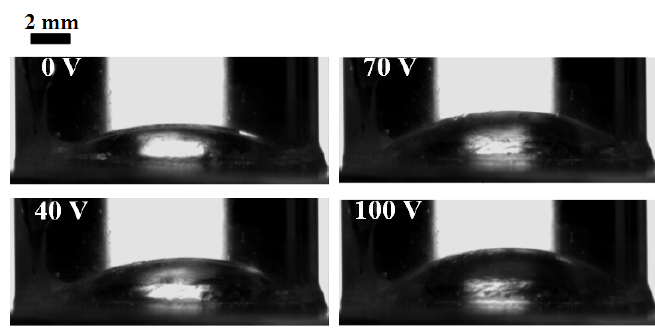
Figure 4. Shape change of oil droplet with increasing voltage. As the applied voltage increases, the oil droplet is squeezed by the surrounding waters and bulges up into a shape with smaller radius of